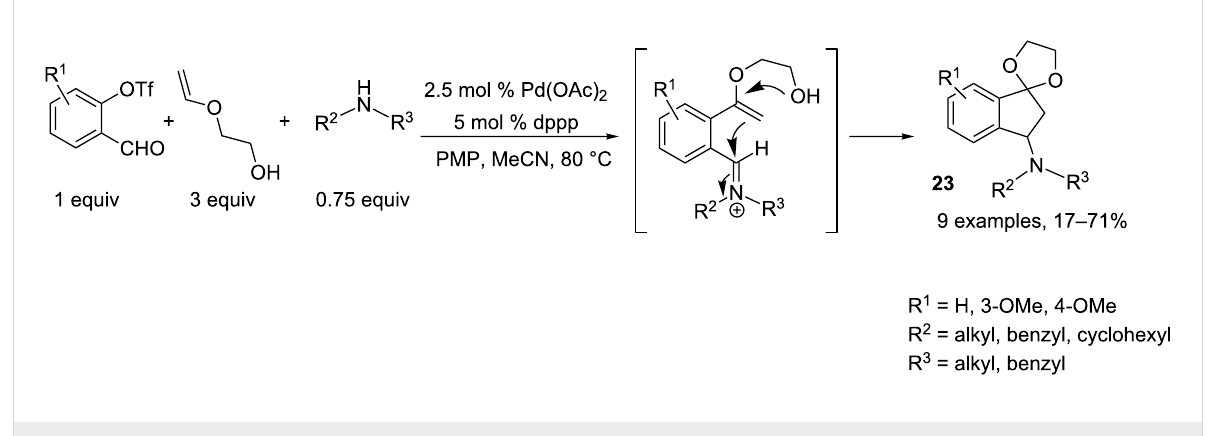
Scheme 12: Synthesis of masked 3-aminoindan-1-ones.